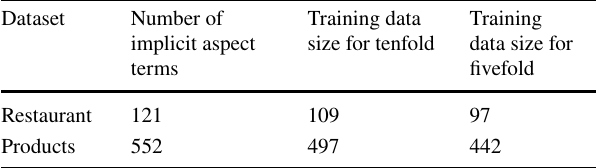
Table 1 Detailed information for the two datasets